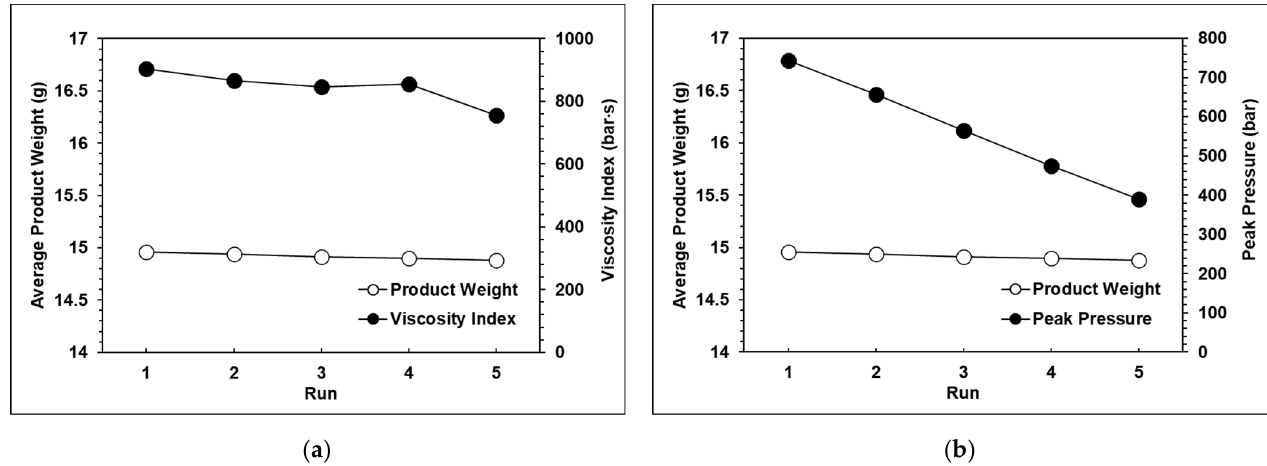
Figure 12. ( a ) Relationship between the product weight and the viscosity index with 40 tons of clamping force; ( b ) Relationship between the product weight and the peak pressure with 40 tons of clamping force.